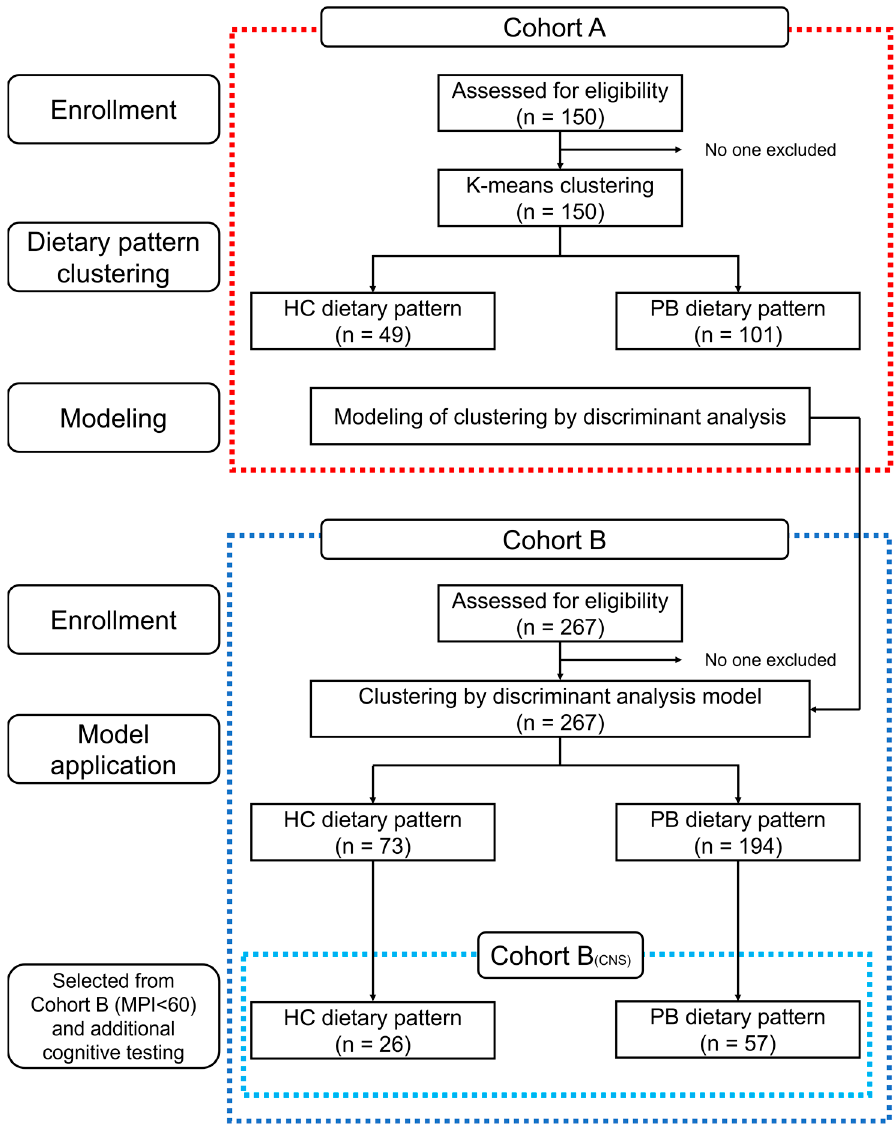
Figure 1. Flow chart showing the number of participants in each phase of Cohorts A, B, and B (CNS) .